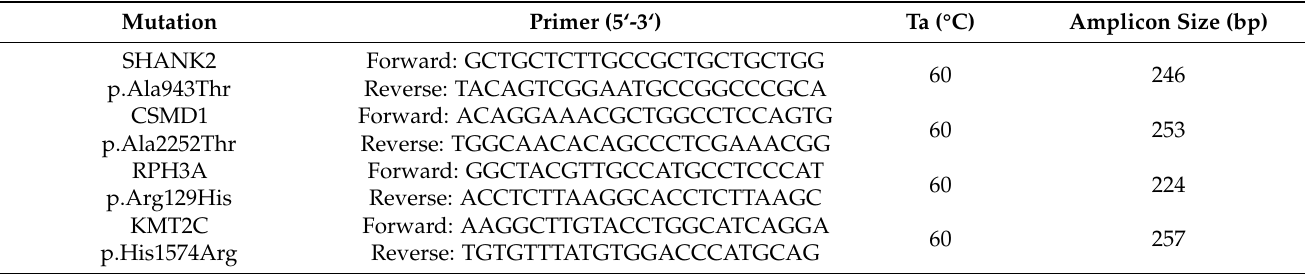
Table 3. Primer sequences, optimal annealing temperature (Ta), and sizes of amplicons of Sanger sequencing in this study.